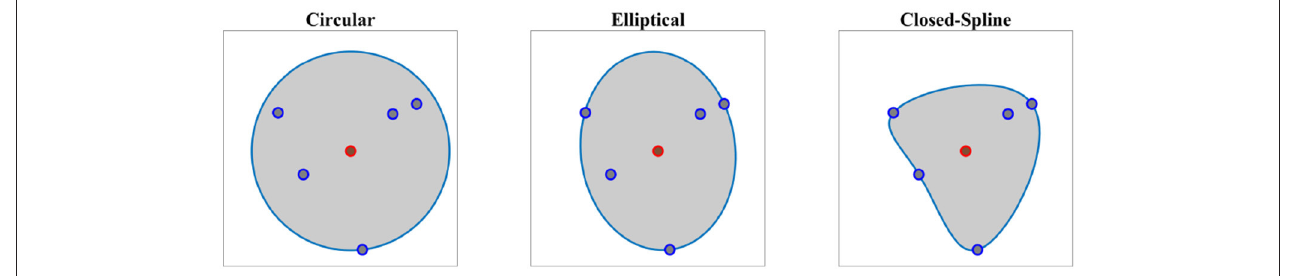
FIGURE 4 | Different types of cross-section on the same set of data. Point on the directrix and the effective points are shown in red and blue respectively.